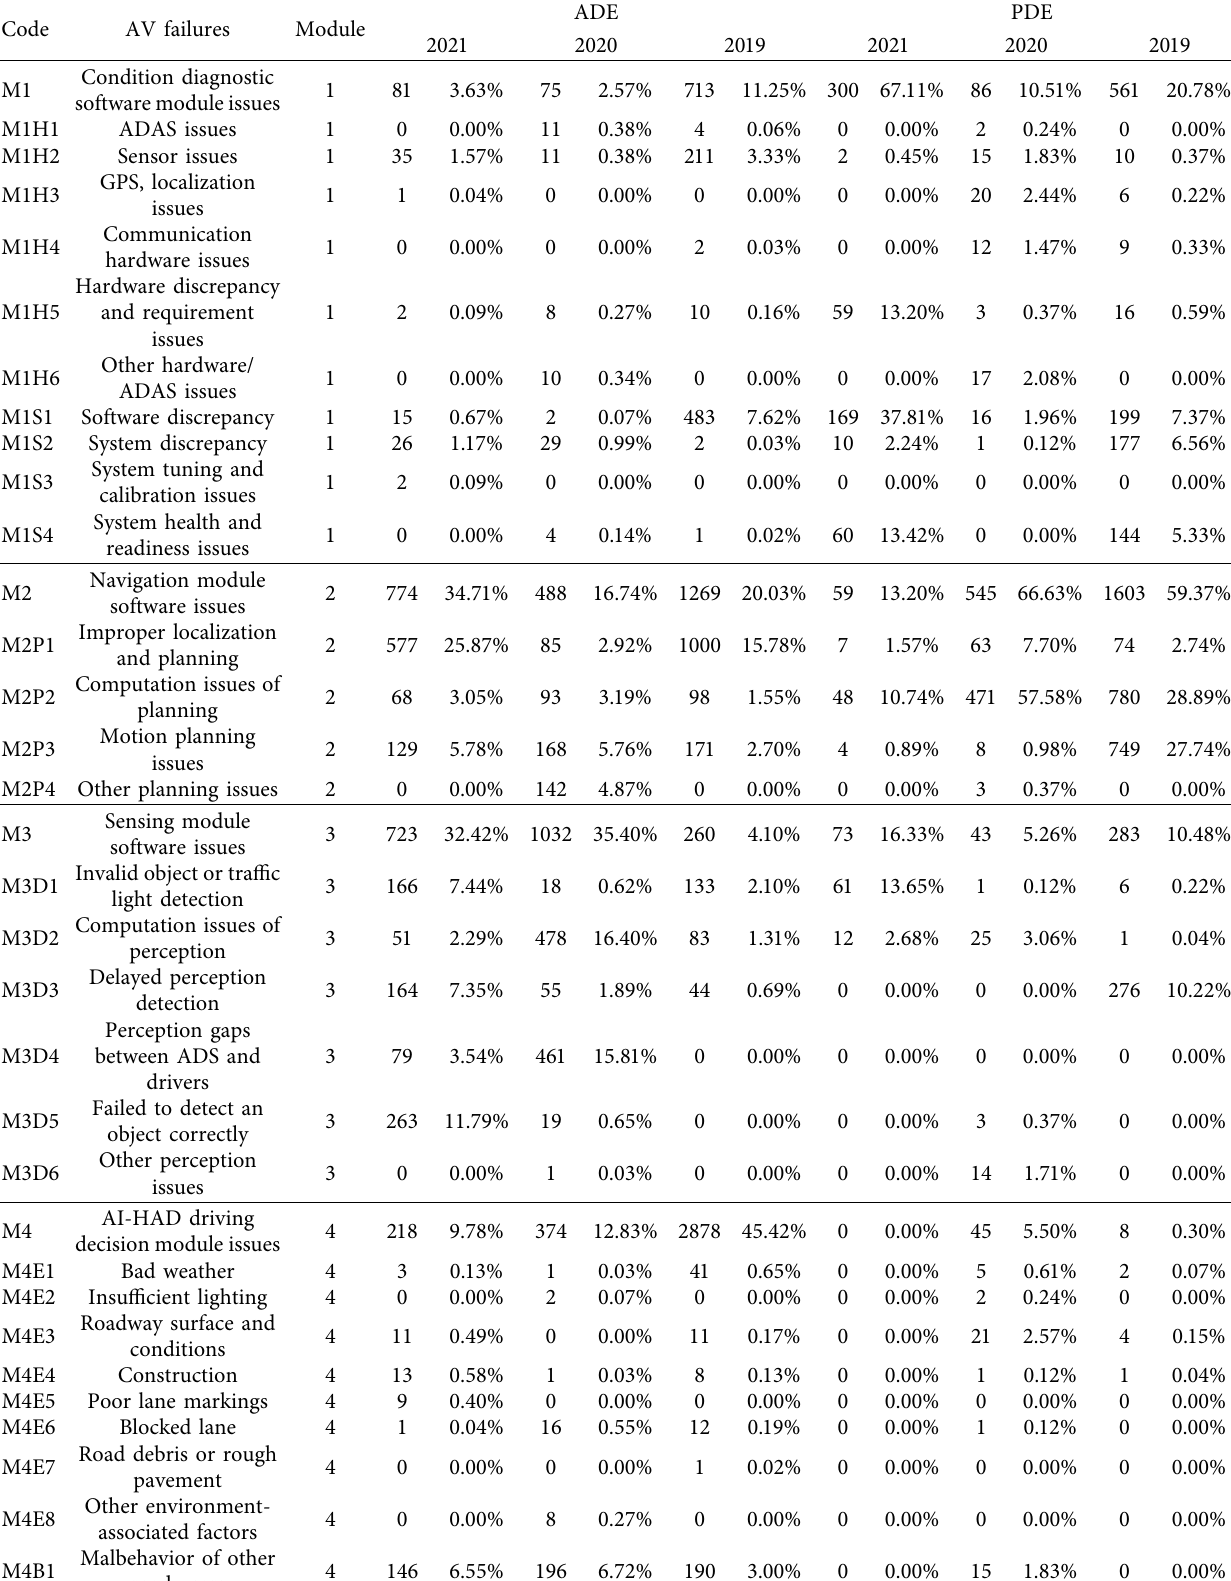
Table 6: Potential risk assessment results through 2019–2021 DMV AVT disengagement reports (grouped by software